Question: Compose a caption that would accompany this figure in a paper.
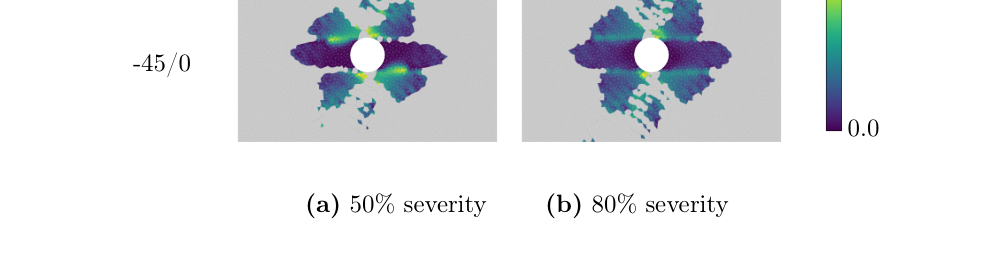
Answer: Local stress ratio field in the cohesive zone for each interface at approximately 7% stiffness loss